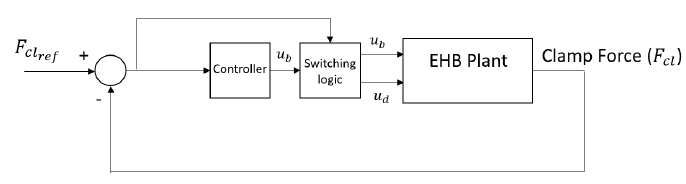
Figure 5. Control scheme for the